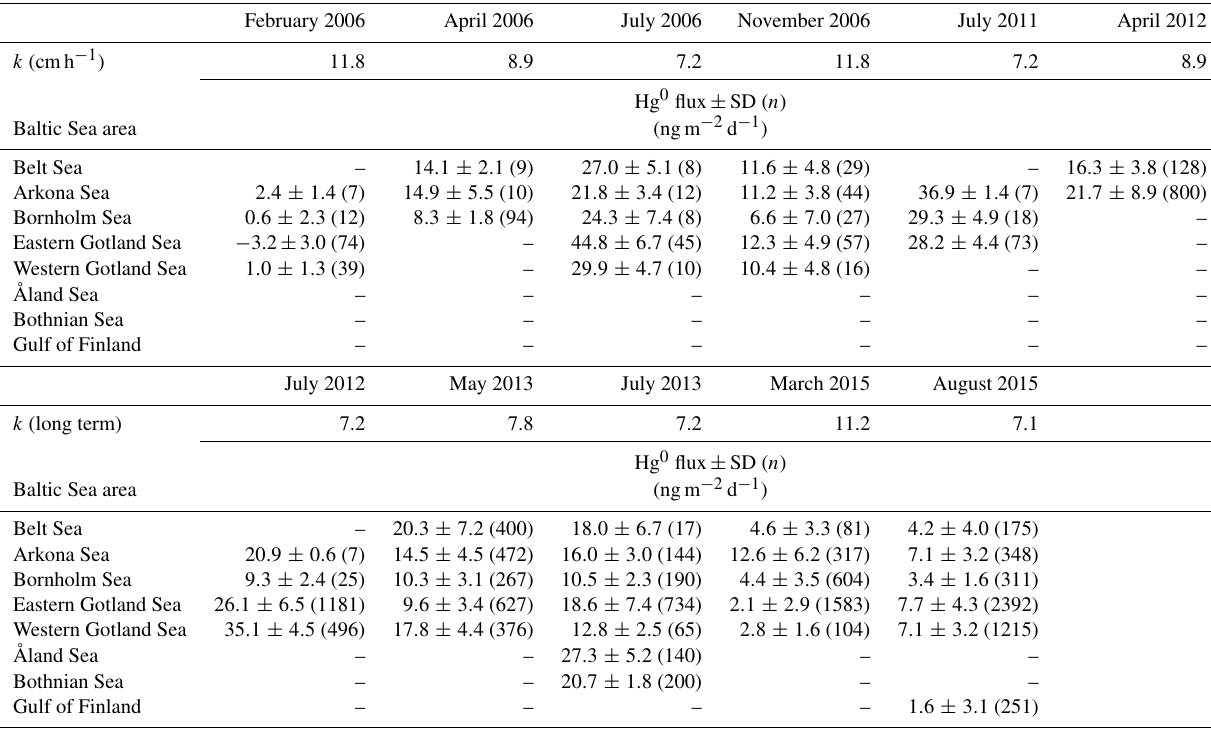
Table 3. Mean ± standard deviation of sea–air fluxes of elemental mercury in Baltic Sea areas based on data obtained between 2006 and 2015. Beginning in April 2012, data were obtained using a membrane equilibrator with a higher data rate. The number of data points is shown in parentheses.